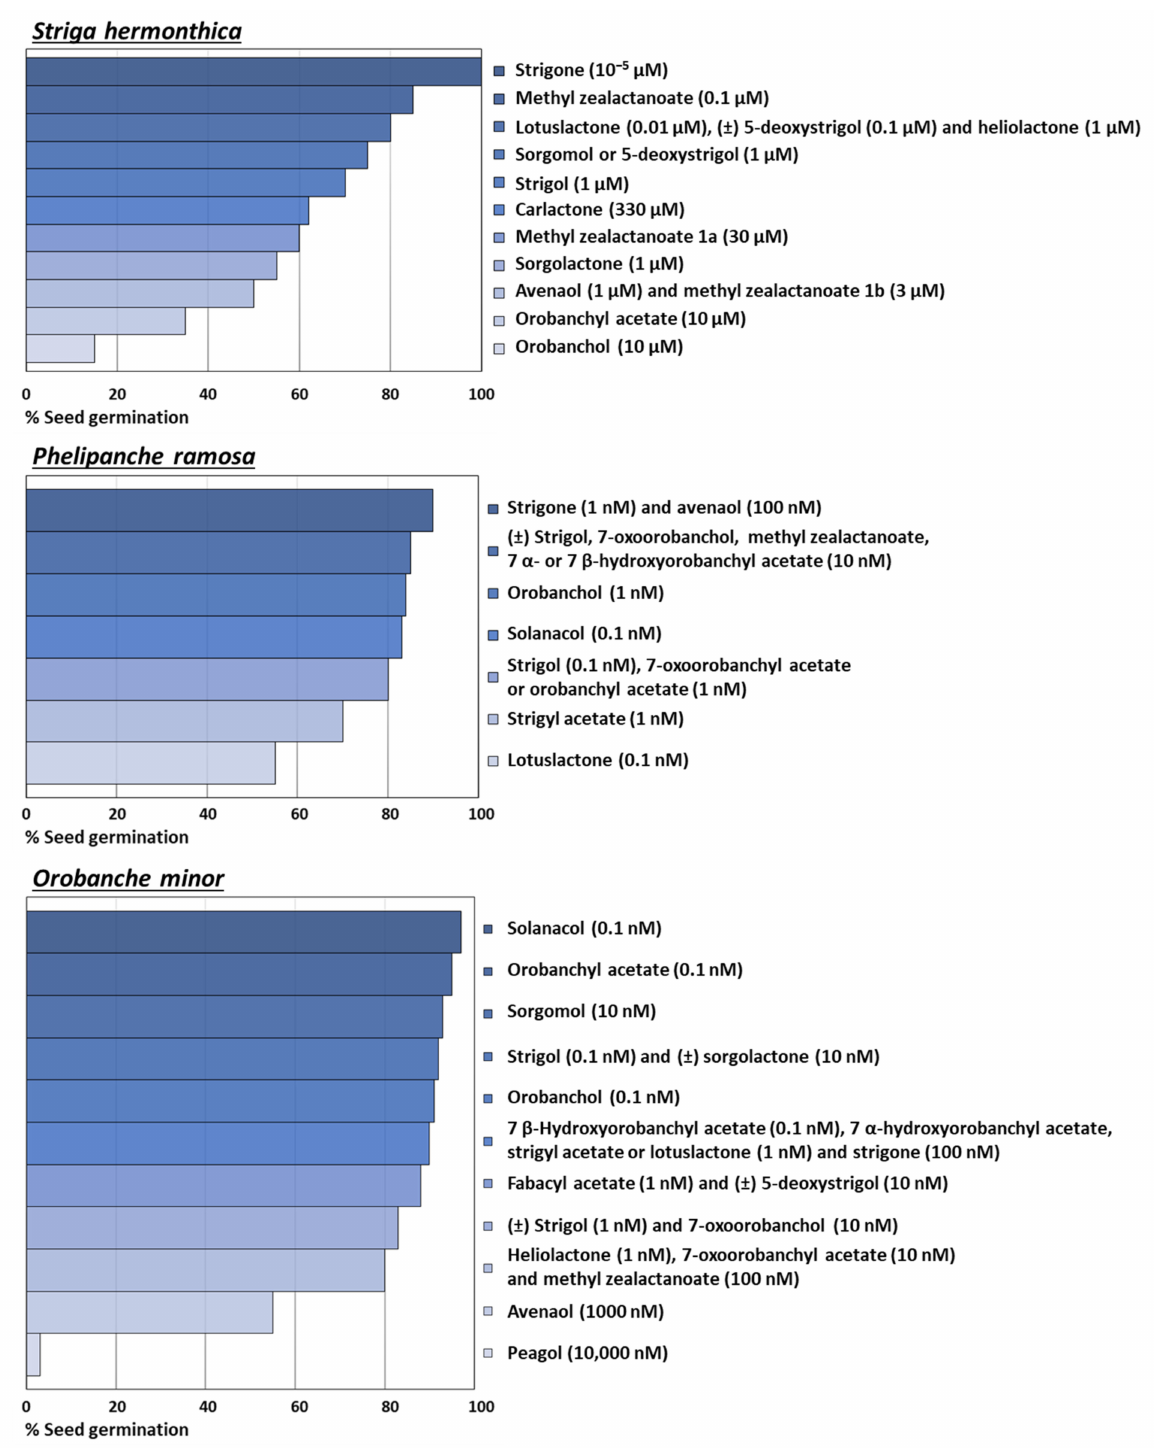
Figure 6. Stimulatory activity levels of the strigolactones tested on Striga hermonthica , Phelipanche ramosa, or Orobanche minor seeds germination, in descending order of